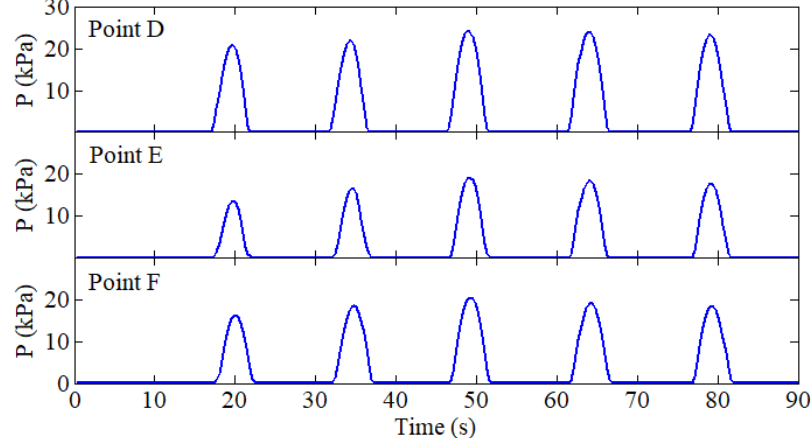
Figure 9. Time history of the wave impact on the different positions on the pile legs 2 m above the static water surface in Case 1 ( H = 7 m, d = 50 m, T = 15 s).